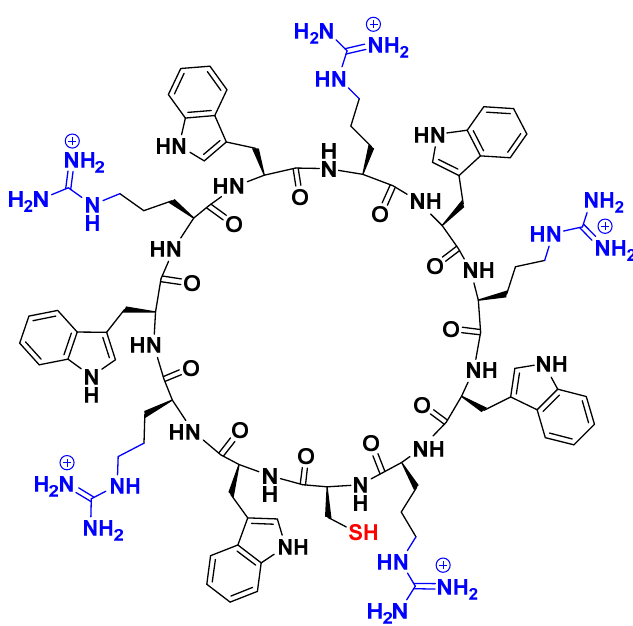
Figure 1. Chemical structures of the cyclic peptide [(WR) 5 C] 1.